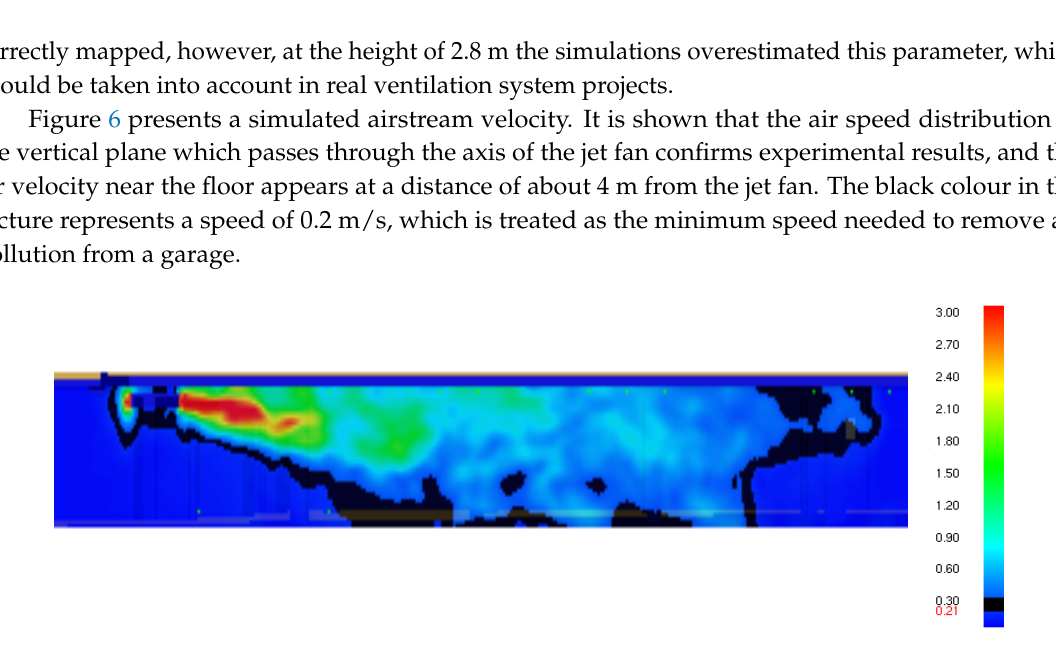
Figure 6. Graphical presentation of a simulated air stream velocity. The scale presents velocity range in (m/s).